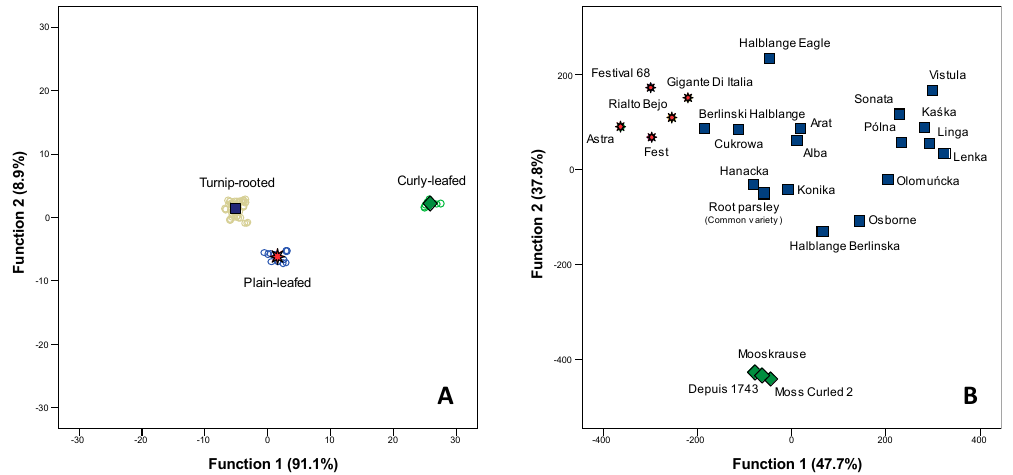
Figure 2. Scatter plots illustrating the distribution of the markers corresponding to ( A ) each type of parsley cultivar and to ( B ) the 25 cultivars according to the canonical discriminant function coefficients.